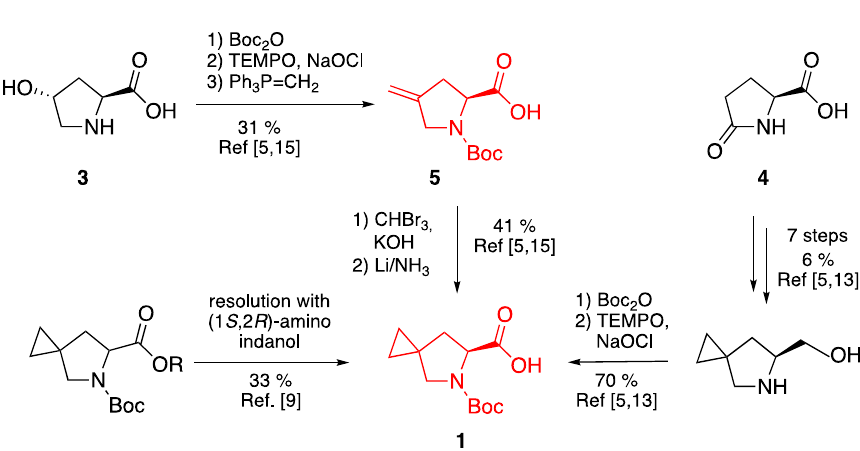
Figure 1. Structure of compounds 1 and 2 .